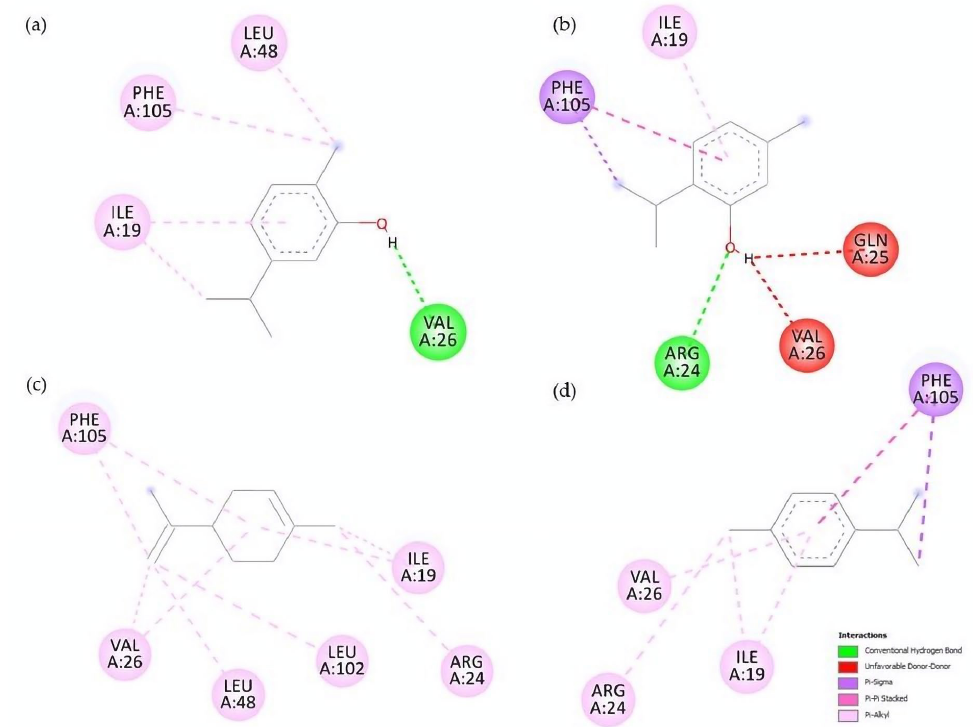
Figure 6. Visualization of SCP-2–ligand interactions: ( a ) carvacrol, ( b ) thymol, ( c ) limonene and ( d ) γ -terpinene.